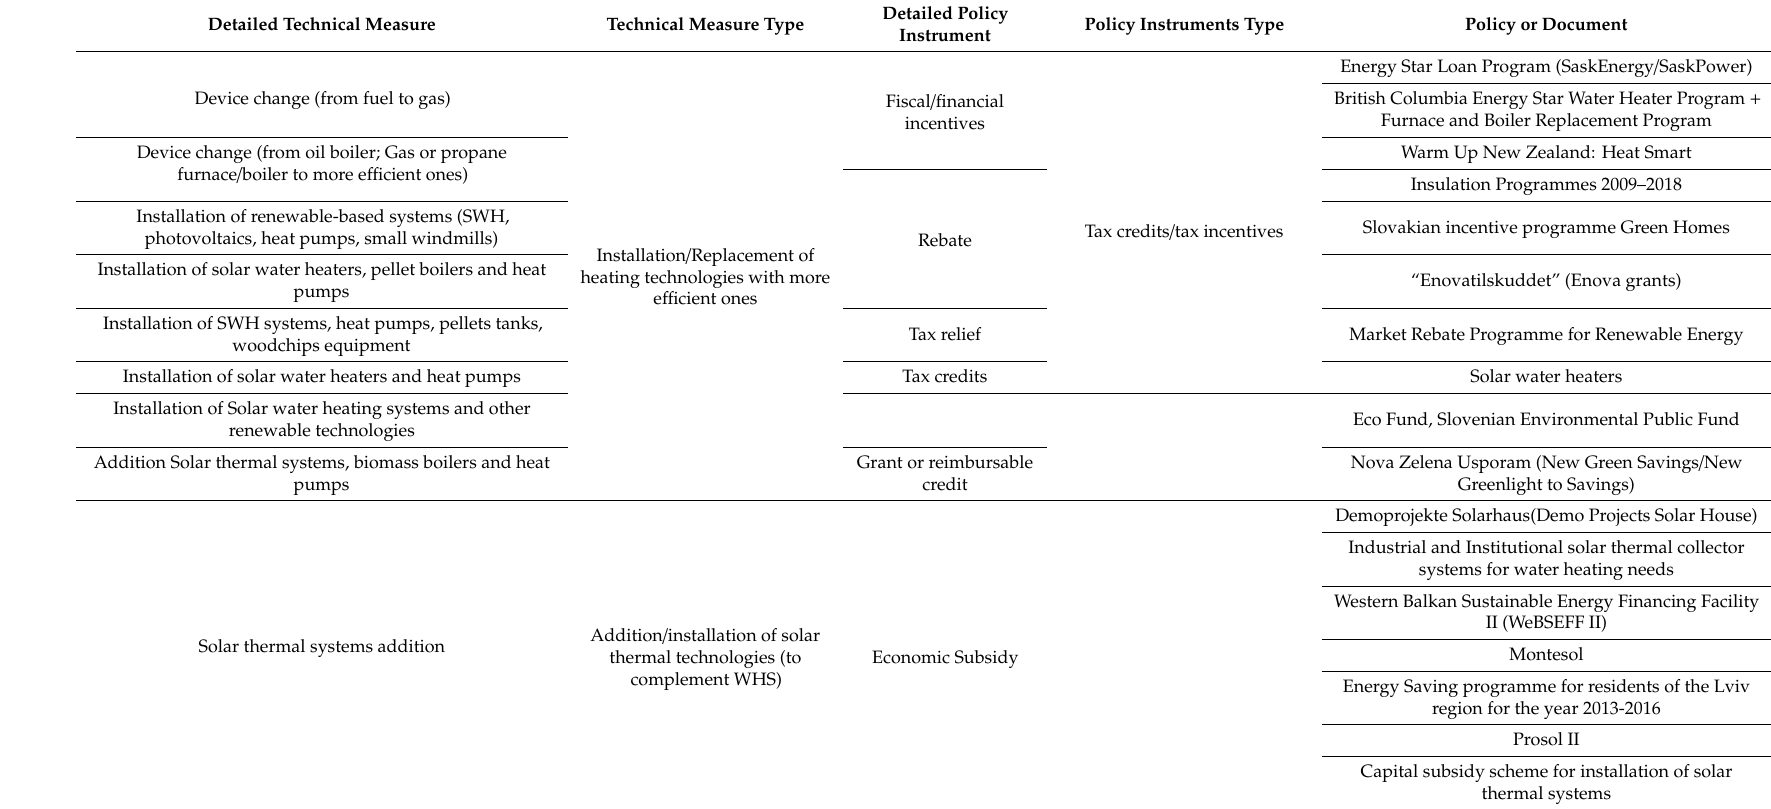
Table A1. Technical measure with policy